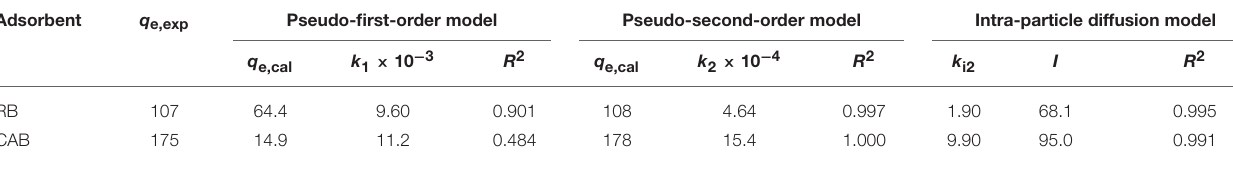
TABLE 3 | Parameters of kinetic models for CR adsorption on RB and CAB. Adsorbent q